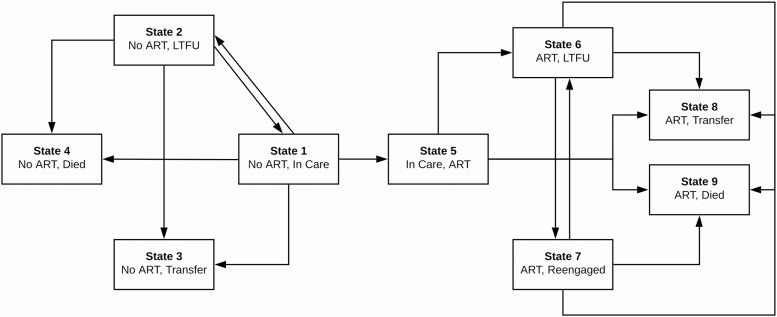
State transitions framework for multistate analysis. At each time point, patients were categorized into 1 of 9 mutually exclusive and exhaustive states: (1) not initiated on ART and in care, (2) out of care prior to initiating on ART, (3) transfer to another clinic prior to initiating ART, (4) death prior to initiating ART, (5) initiated on ART and consistently in care (ie, no LTFU after initiating ART), (6) out of care after initiating ART, (7) reengaged in care at the original clinic after LTFU on ART, (8) transfer to another clinic after initiating ART, and (9) death after initiating ART. This figure depicts all the possible transitions patients could make from each state. Abbreviations: ART, antiretroviral therapy; LTFU, lost to follow-up.